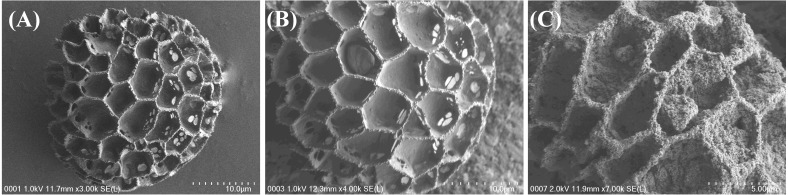
FESEM images of synthesized adsorbent.FESEM images of (A) sporopollenin, (B) Sp-TDI-calix and (C) MSp-TDI-calix.